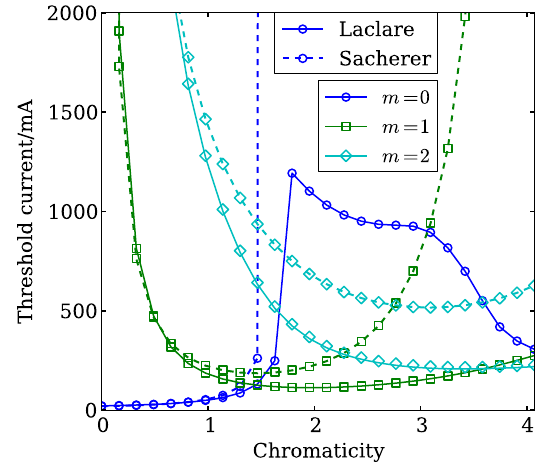
FIG. 3. Comparison of the Laclare eigenvalue method with the Sacherer approximation when both are applied to the case of the short bunch in a single RF